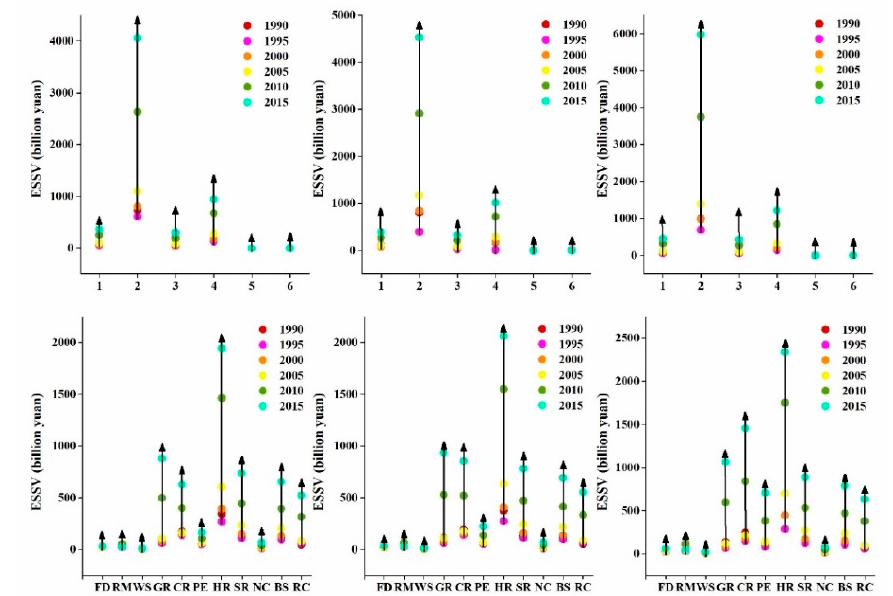
Figure 5. Ecosystem service scarcity values considering the simultaneous influence of supply and demand during 1990–2015 in the Exibei region. 1: farmland; 2: forestland; 3: grassland; 4: water body;